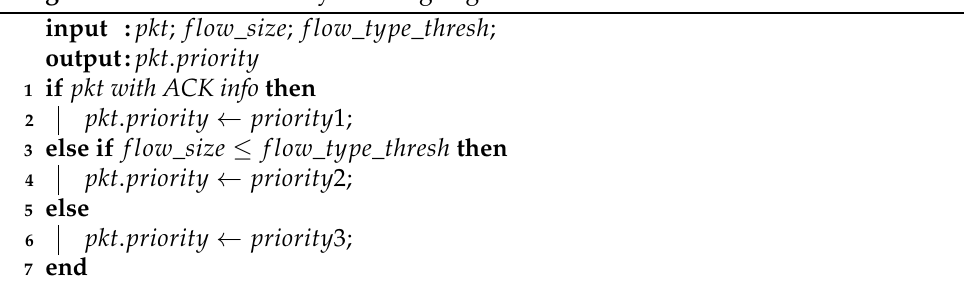
Algorithm 1: Packet Priority Marking